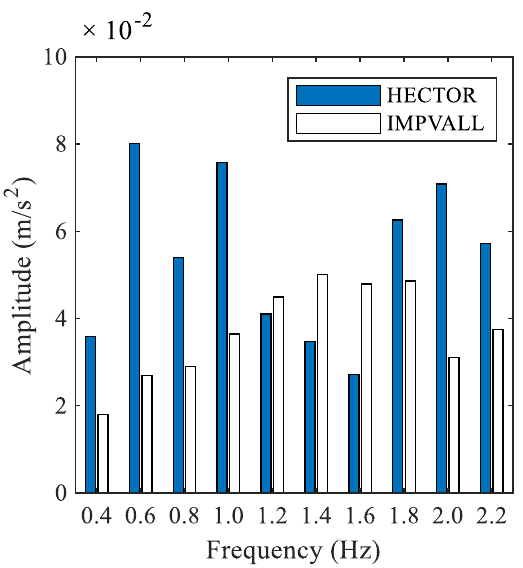
Figure 6. Ten feature values of ground motions.